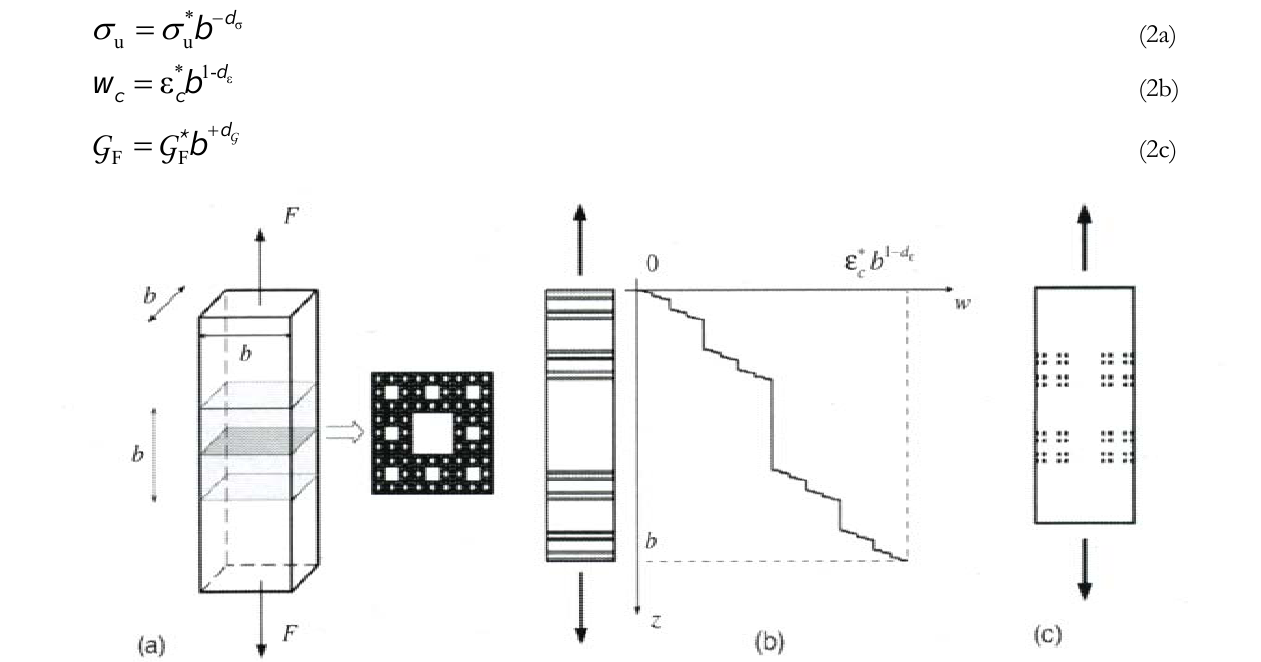
Figure 3: A concrete specimen subjected to tension. Fractal localization of the resistant cross section (a); fractal localization of the strain (b) and the energy dissipation inside the damaged band